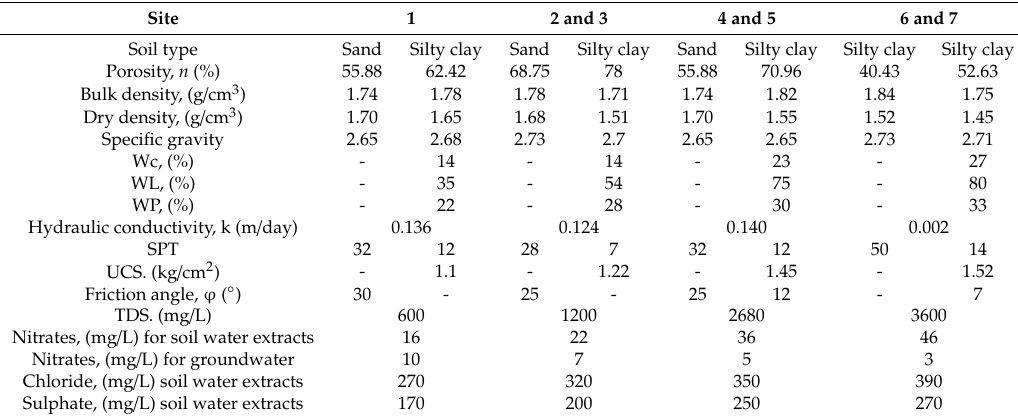
Table 1. Soil properties and geochemical parameters at the di ff erent study